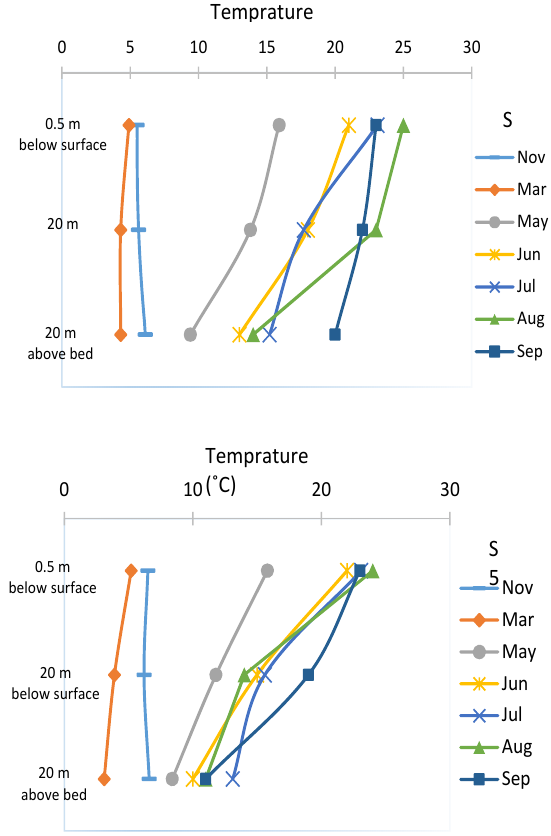
Fig. 4: Variation of temperature in the two stations (S3 and S5) of the studied reservoir at three depths (0.5 m from the surface, 20 m below the surface and 20 m above the bottom of the